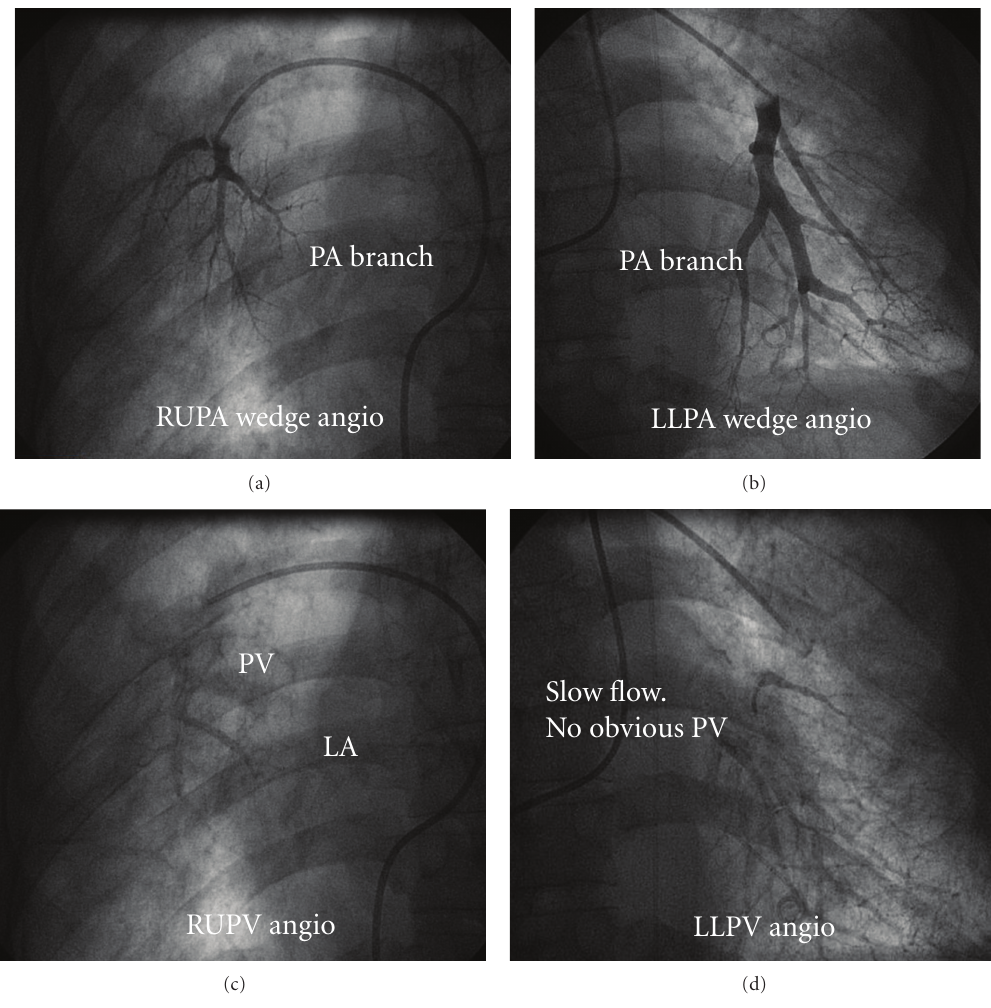
Figure 2: Pulmonary vein wedge angiography. In panel (a) balloon occlusion with hand contrast injection demonstrates opacification of the distal branches of the right upper pulmonary artery (RUPA) and in panel (b) the levophase of the wedge angiogram shows normal right upper pulmonary vein (RUPV) drainage into the left atrium (LA). Panel (c) shows normal opacification of the distal branches of the left lower pulmonary artery (LLPA) with wedge angiography. However, during the levophase in panel (d), there is abnormal drainage of the left lower pulmonary vein (LLPV) with contrast persisting in the LLPA and the absence of contrast media in the LA diagnostic of